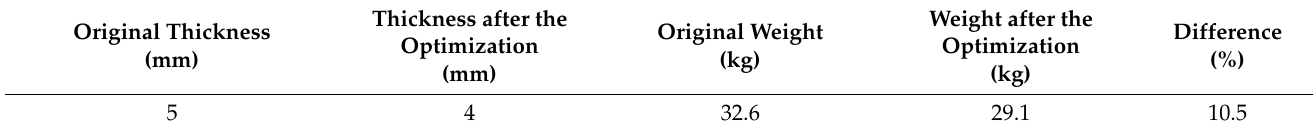
Table 6. Comparison of thickness and mass of crossbars, before and after design optimization.